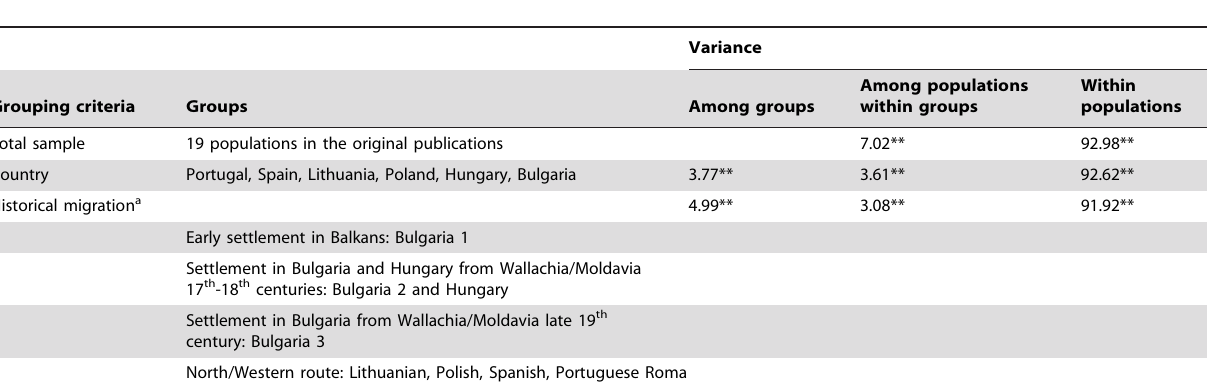
Table 2. AMOVA with mtDNA sequences from the Roma populations